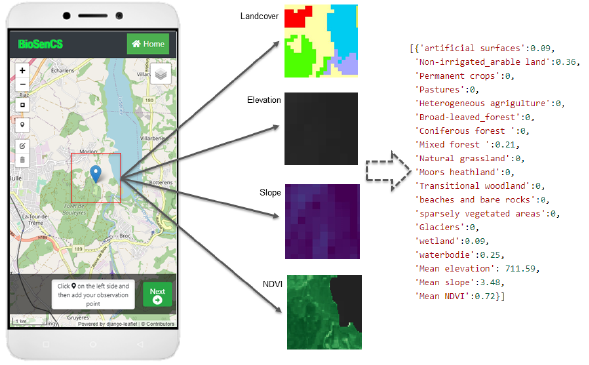
Figure 10. Extraction of environmental variables in a neighbourhood of 1km around the location of observation added by the participant